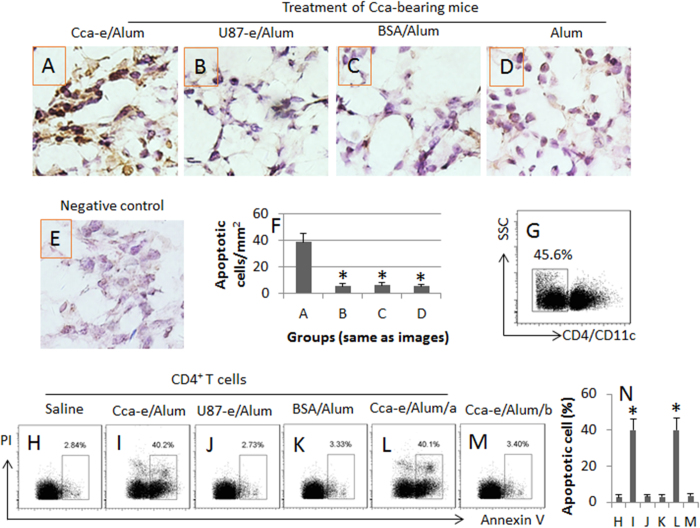
Assessment of Cca cell apoptosis.A–E, Cca tissue was excised from the Cca-bearing mice after treatment (as denoted above each image) and processed the cryosections for TUNEL staining. The images show the apoptotic cells (stained in brown). F, the bars indicate the frequency of apoptotic cells averaged from 30 fields/sample. G, CD4+ CD25+ CD127+ T cells (in short, CD4+ T cells) were isolated from the excised Cca tissue and cultured with Cca cells (at a ratio of 1:1) for 3 days in the presence of CD11c+ DC. The gated cells are Cca cells (WT-CT-210 cells) and were further analyzed by flow cytometry. H–L, the gated cells indicate Annexin V+ and propidium iodide (PI)+ apoptotic cells. The sources of samples are denoted above each subpanel. Cca-e/Alum-a: The experiments were done in Transwell system. Cca-e/Alum/b: CD4+ T cells were isolated from Cca-bearing IL-9-deficient mice. N, the bars indicate the summarized data of apoptotic cells of panels H–L. The data of bars in F and M are presented as mean ± SD. *, p < 0.01, compared with A (F), or H (M). The data are representatives of 3 independent experiments.